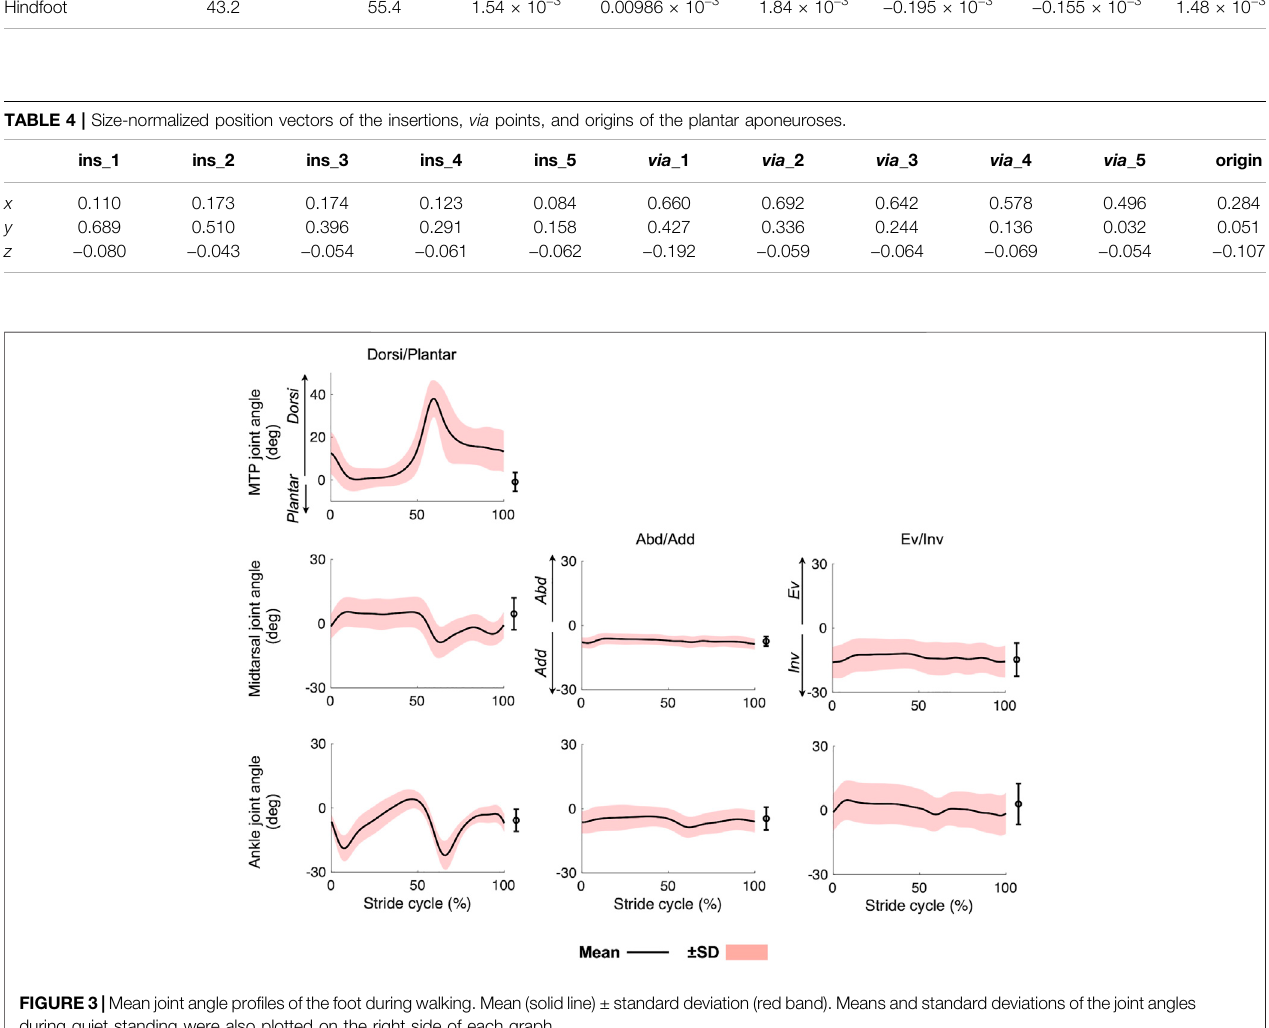
Frontiers in Bioengineering and Biotechnology |